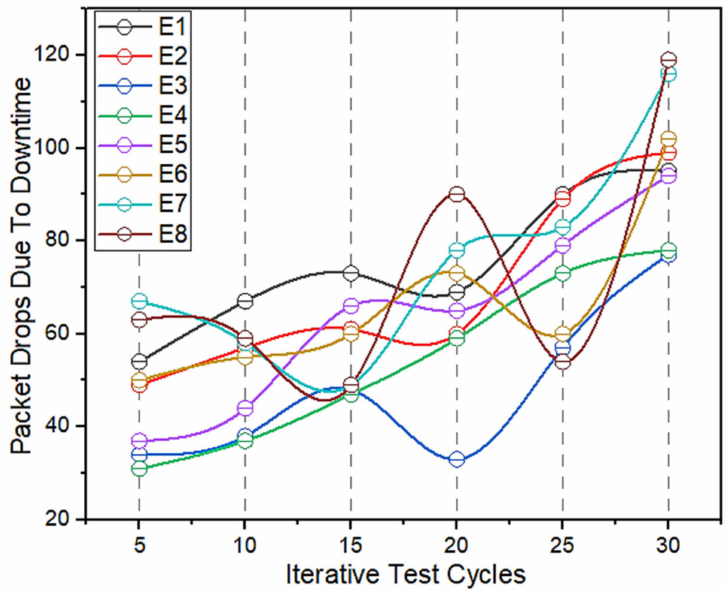
Figure 13. Total number of packets dropped due to sensor node’s